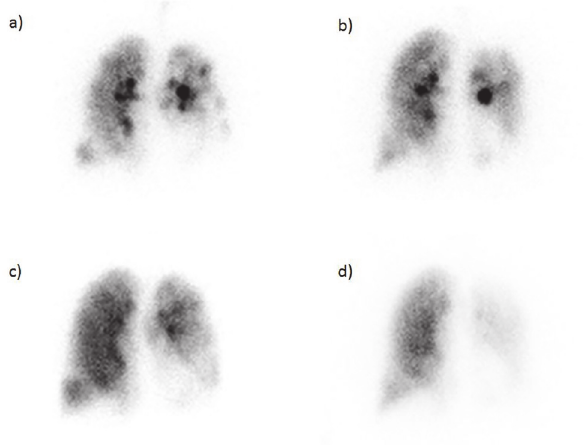
Fig 1. Pulmonary scintigraphy with ventilatory (a) pre-procedural, b) post-procedural) and perfusional (c) pre-procedural, d) post-procedural) imaging in a left upper lobe treated